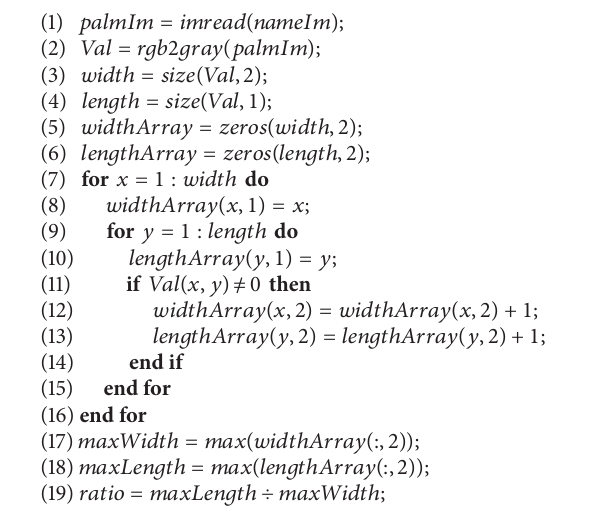
Algorithm 1: Extraction algorithm.